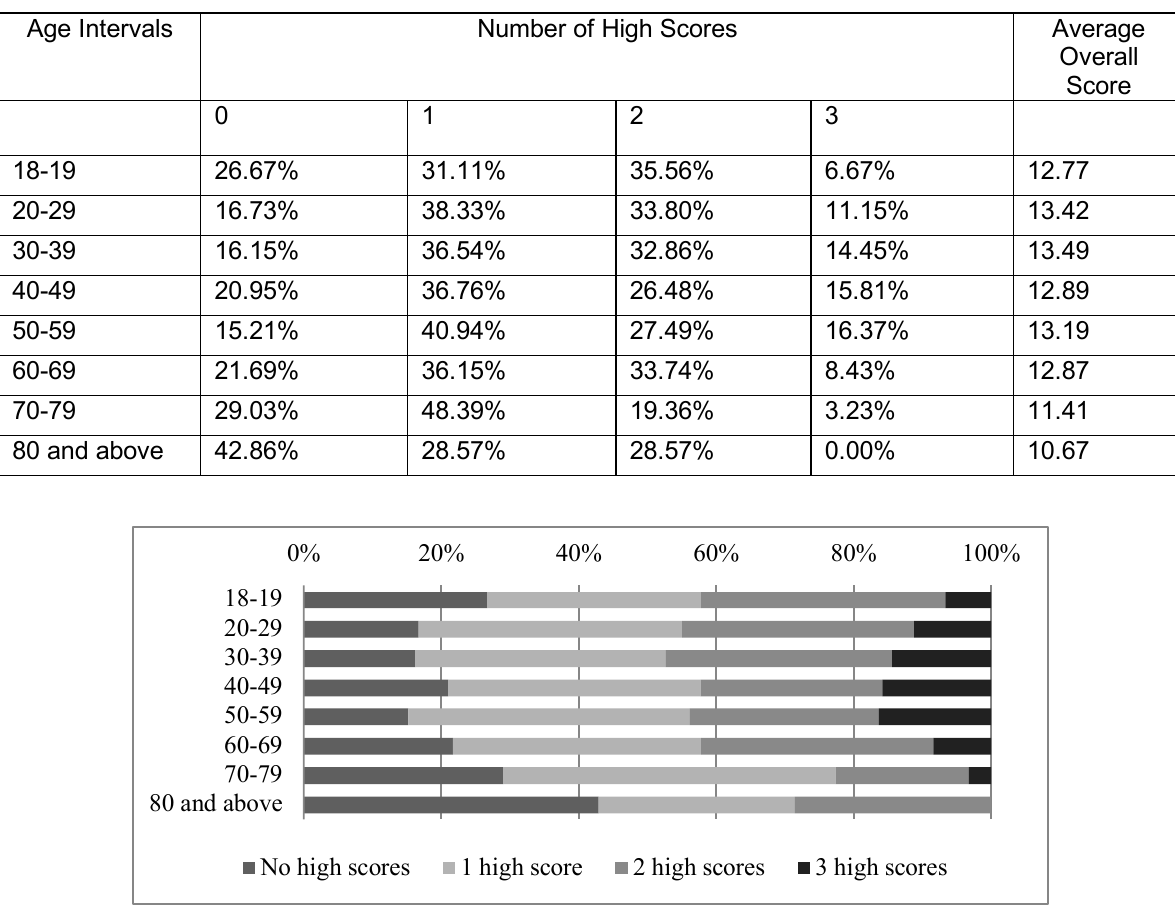
Table 6: Financial Literacy Segments by Age